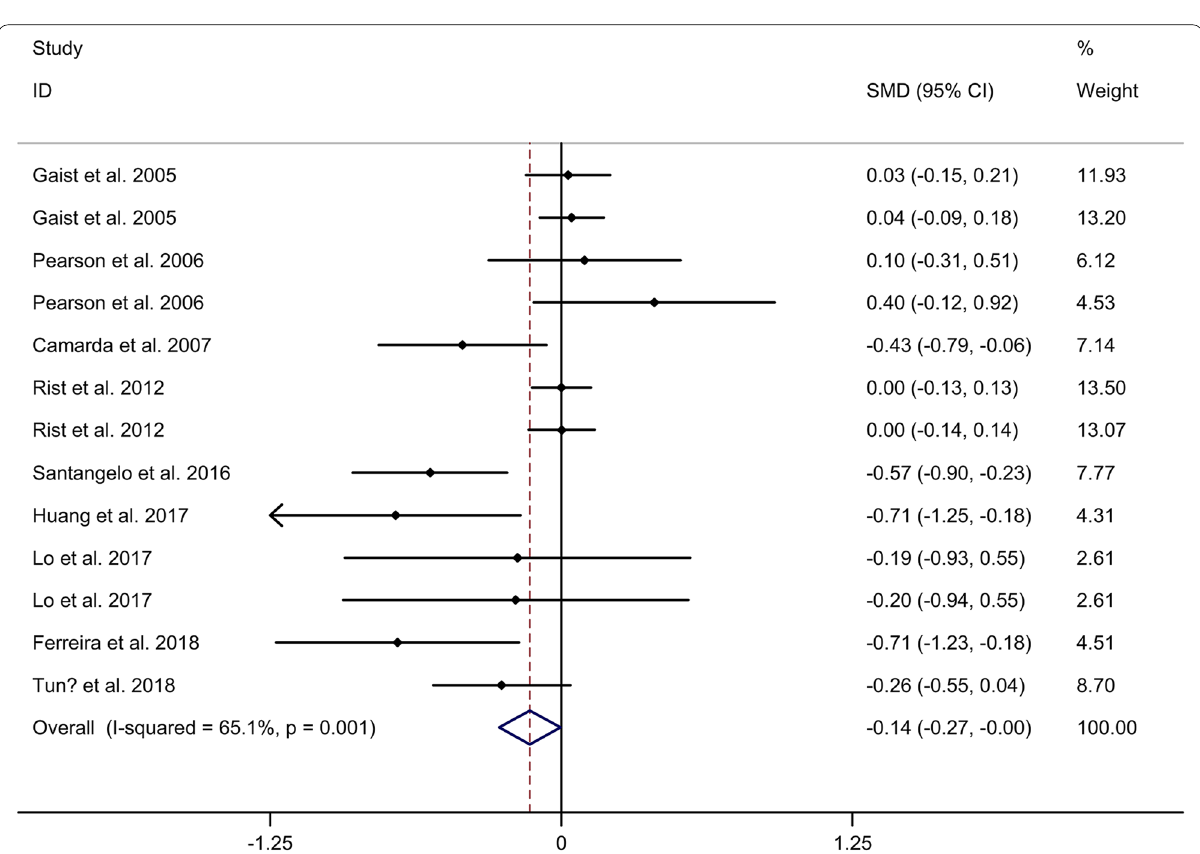
Fig. 2 Forest plots regarding comparison in language function between migraine group and no migraine group. Abbreviations: CI, confidence interval; SMD, standard mean